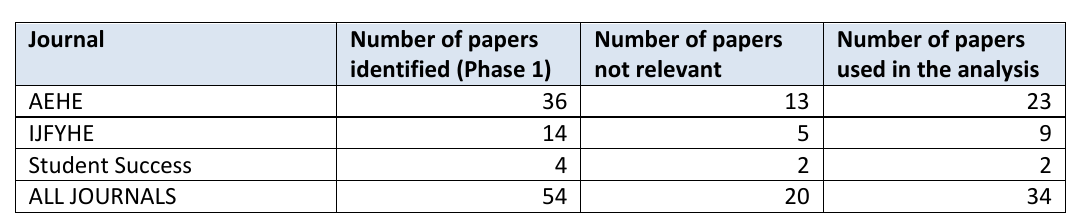
Table 1: Journal papers considered for